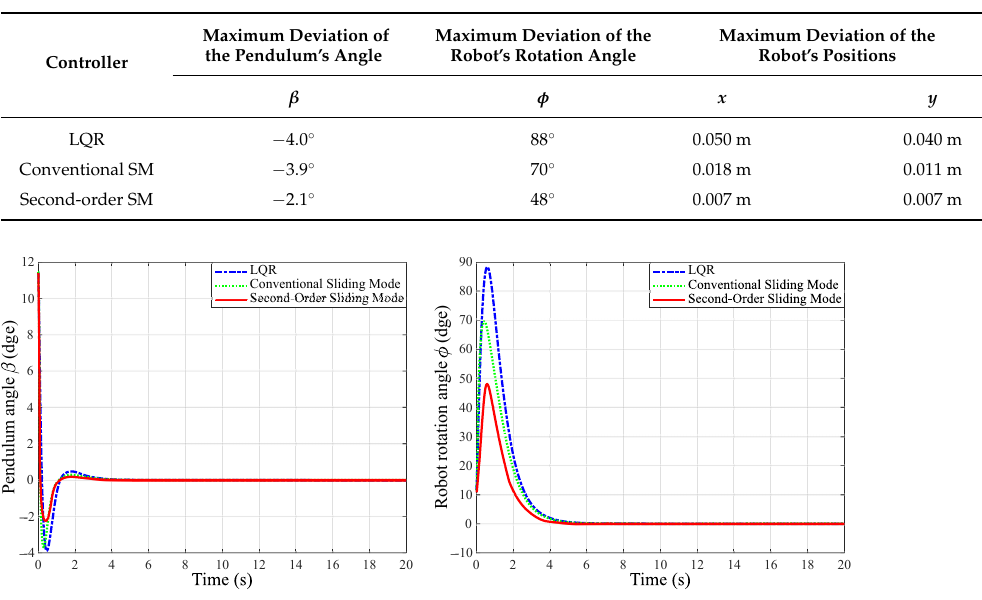
Table 1. The simulation results of the maximum deviations of the pendulum’s angle, the robot’s rotation angle, and the robot’s positions.